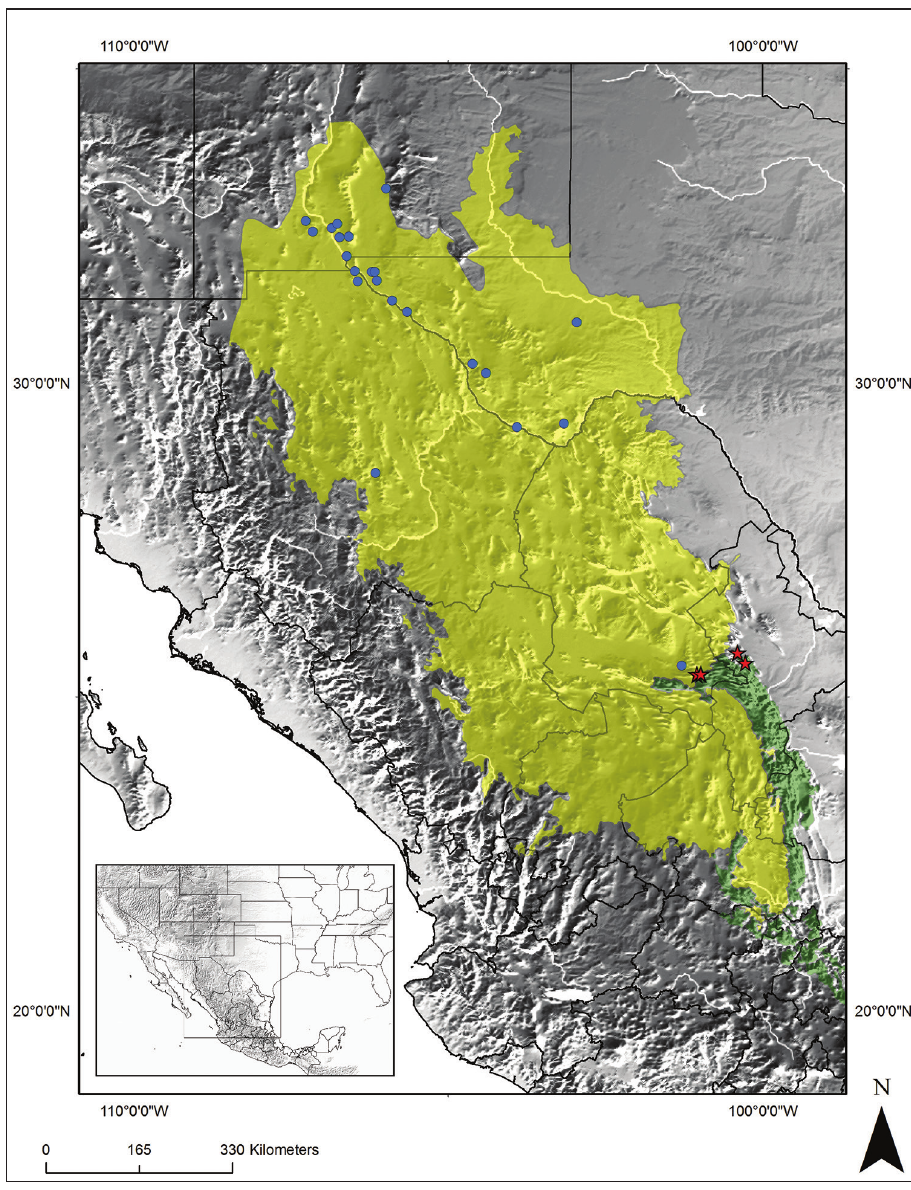
Figure 1. Geographical distribution of Trachymyrmex pakawa n. sp. and its closest relative, Trachymyrmex smithi , in the southwestern USA and northern Mexico (from Rabeling et al. 2007 and this study). Red stars: collection records of T. pakawa. Blue circles: reported collection points of T. smithi . Yellow area, Chihuahuan desert. Green area, Sierra Madre Oriental mountain range. Helicon Focus software (Helicon Soft, Ltd., Kharkov, Ukraine). Minor corrections (color, background, etc.) were made using Adobe Photoshop CS5 (Adobe Systems, San Jose, CA